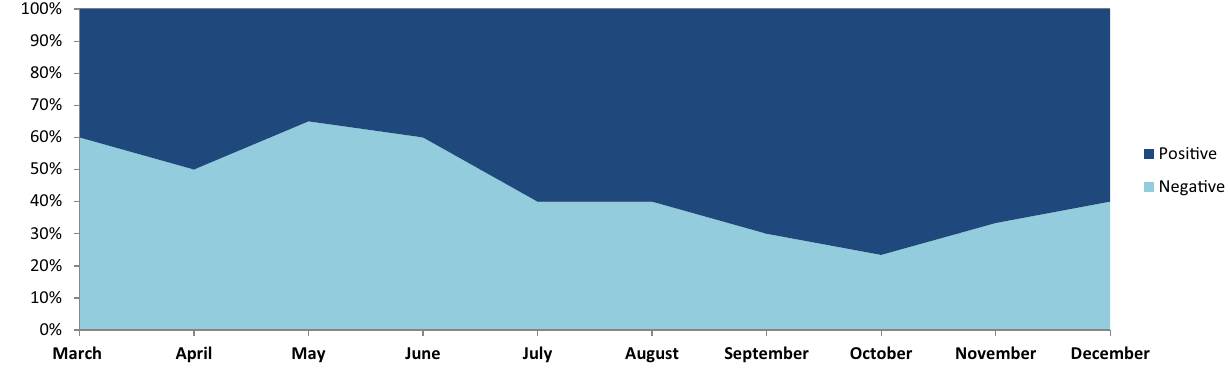
Figure 2. The overall public opinion discussed during Covid-19 pandemic condition month-wise result analysis.